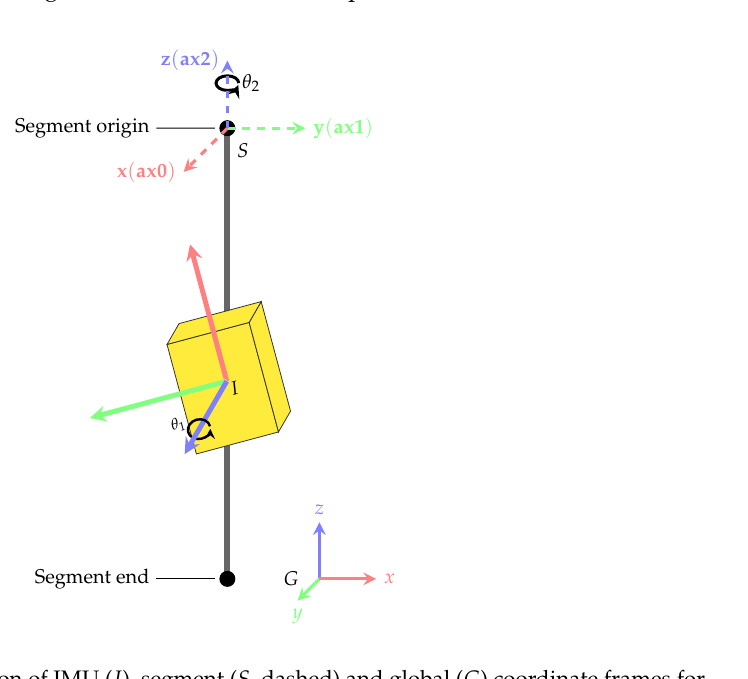
Figure 4. Exemplary illustration of IMU ( I ), segment ( S , dashed) and global ( G ) coordinate frames for one IMU and one segment. The I2S alignment variations in terms of axes and angles ( θ 1 , θ 2 ) as basis for IMU data simulation are also